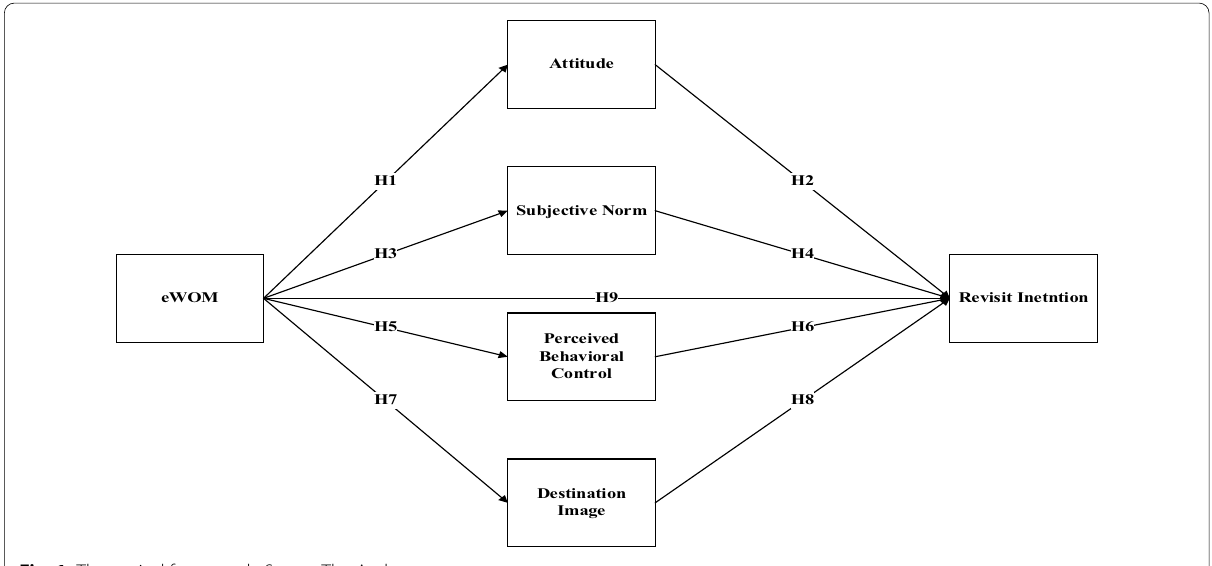
Fig. 1 Theoretical framework. Source : The Authors